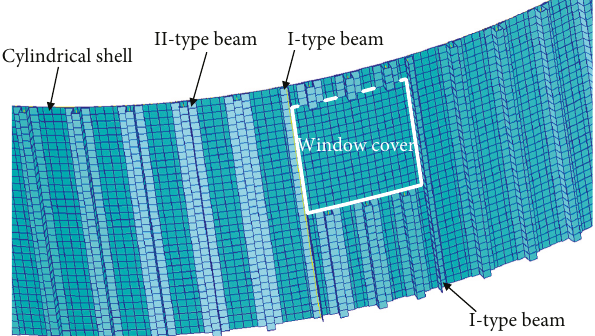
Figure 4: Finite element model of the